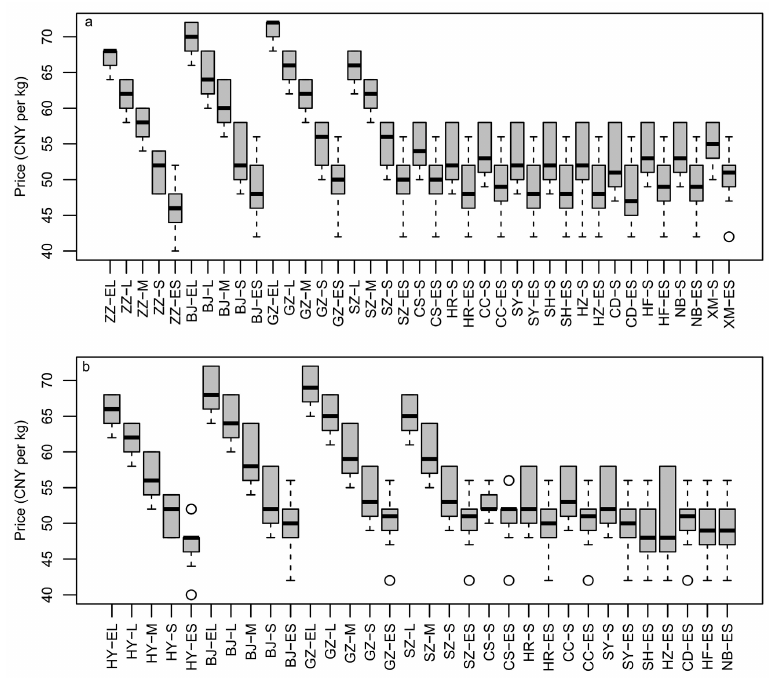
Figure 3. The boxplot of the price series. ( a ) ZZ group; ( b ) HY group. The front code (collection location; see Table 2) and back code (specification; see Table 1); the same below.